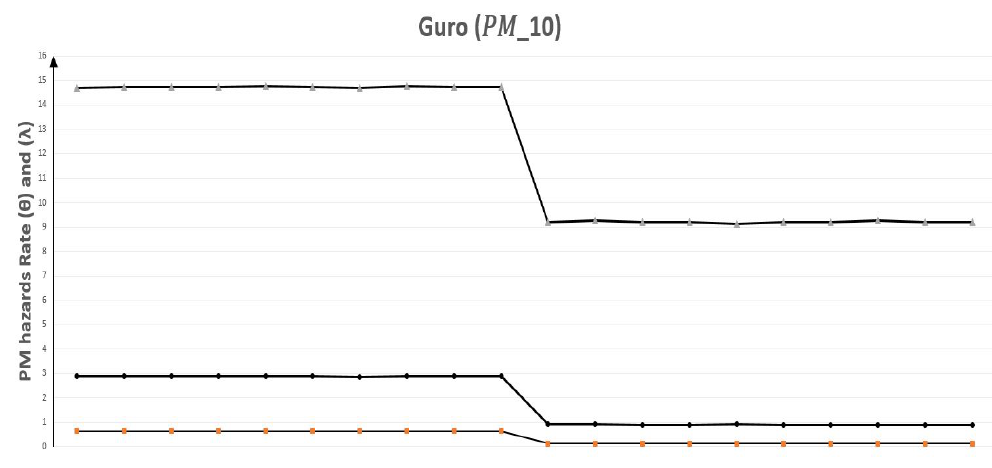
Figure 19. Guro (Seoul, South Korea) monthly polluted days before and after the change point due to PM 10